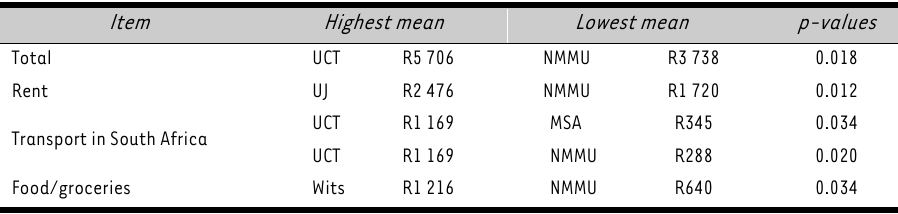
Table 5: Statistically significant differences in spending